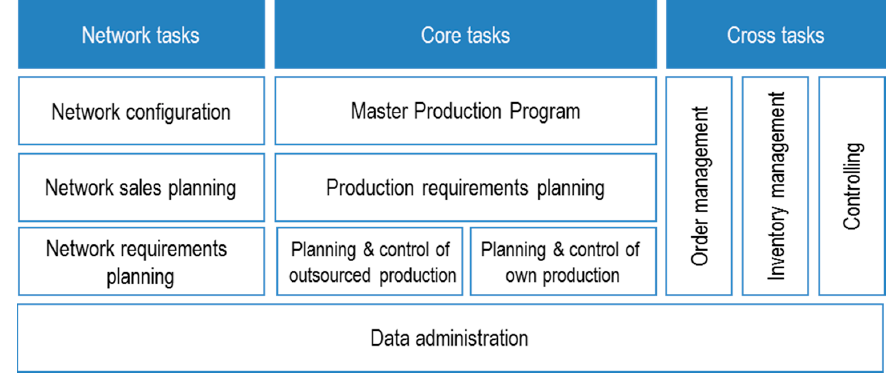
Figure 2. Production management tasks acc. to the Aachener PPC [33] (p. 30).